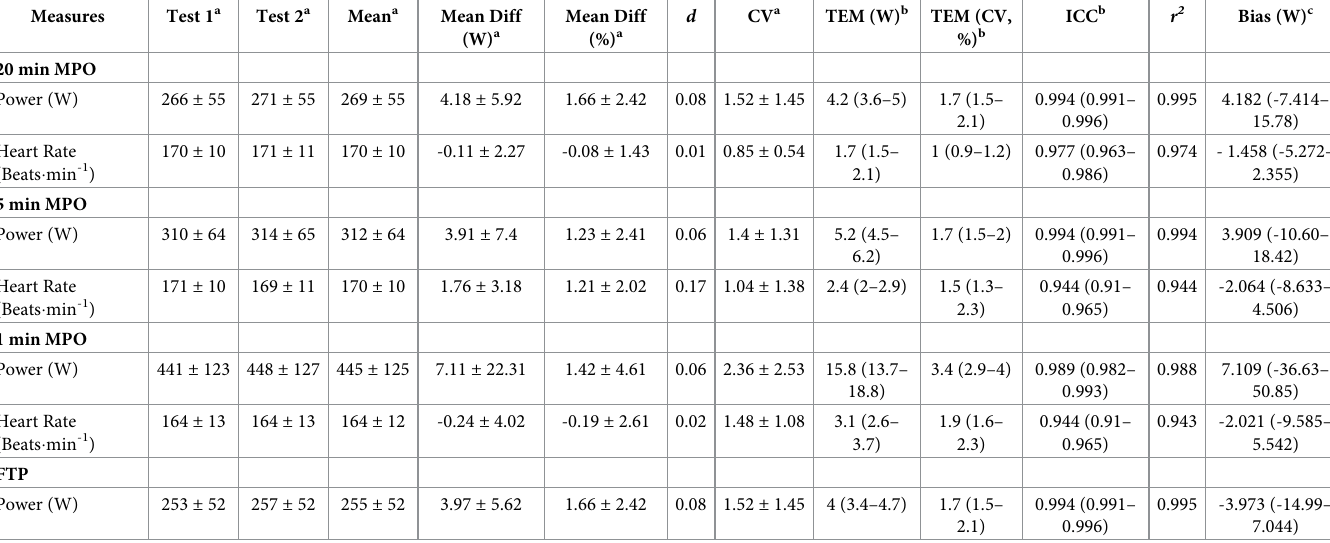
Table 4. Mean power output and heart rate data across first and second re-tests, and reliability statistics between re-tests.